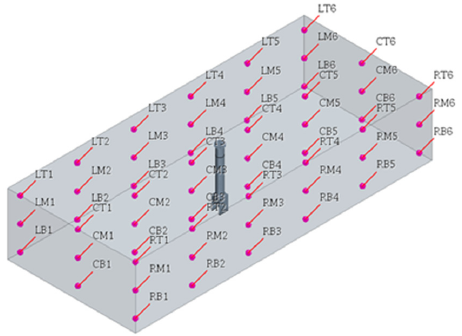
Figure 6. Air flow velocity points.